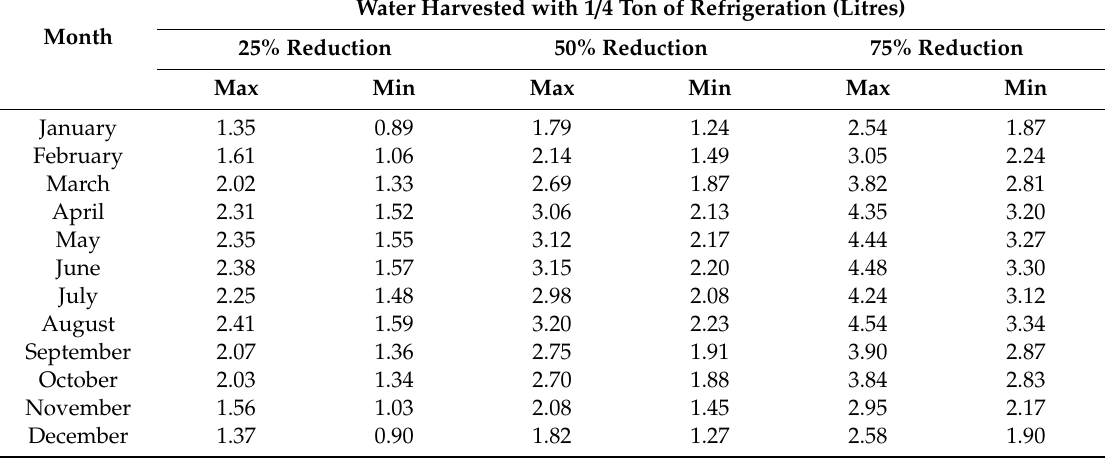
Table 6. Maximum and minimum amounts of water harvested in the months of the year with a compressor with 1 ton of refrigeration 4